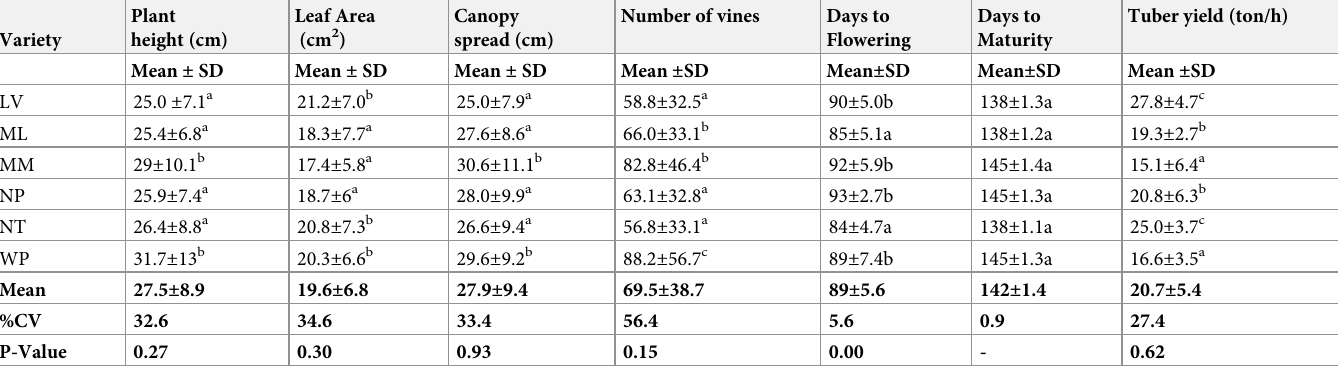
Table 2. Mean values of the growth and yield parameters of frafra potato varieties. Plant Variety height